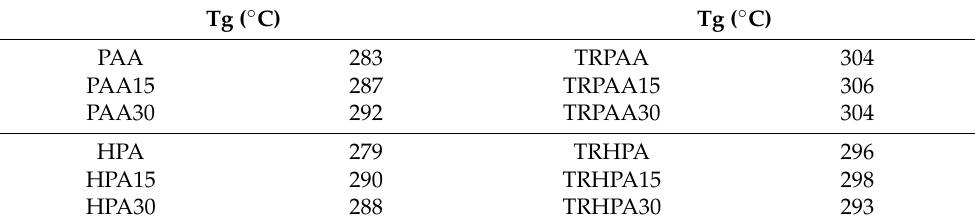
Table 2. Tg of the PAA and HPA membranes before and after thermal treatment as a function of PPN content. Tg ( ◦ C) Tg ( ◦ C) PAA